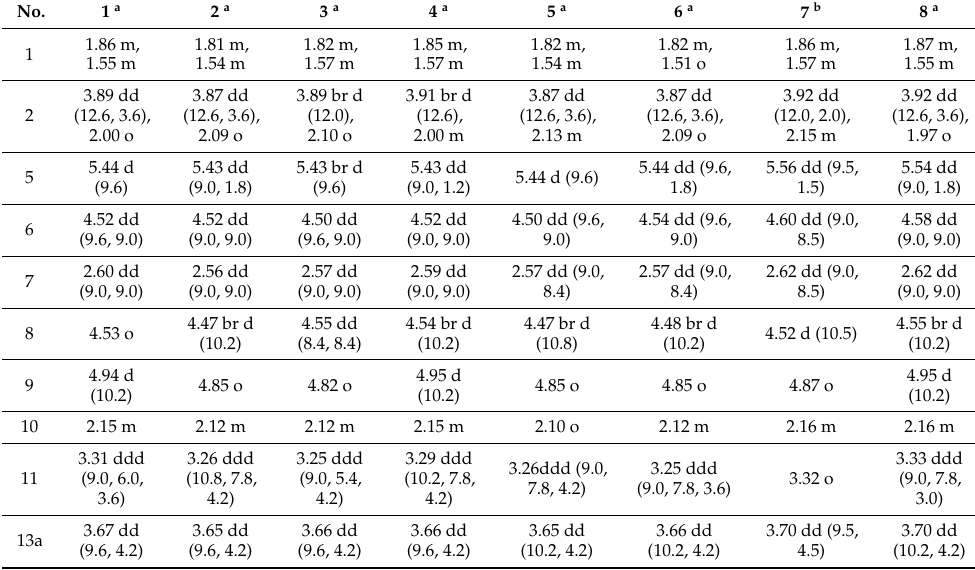
Table 1. 1 H NMR spectroscopic data for compounds 1 – 8 ( δ in ppm, J in Hz).